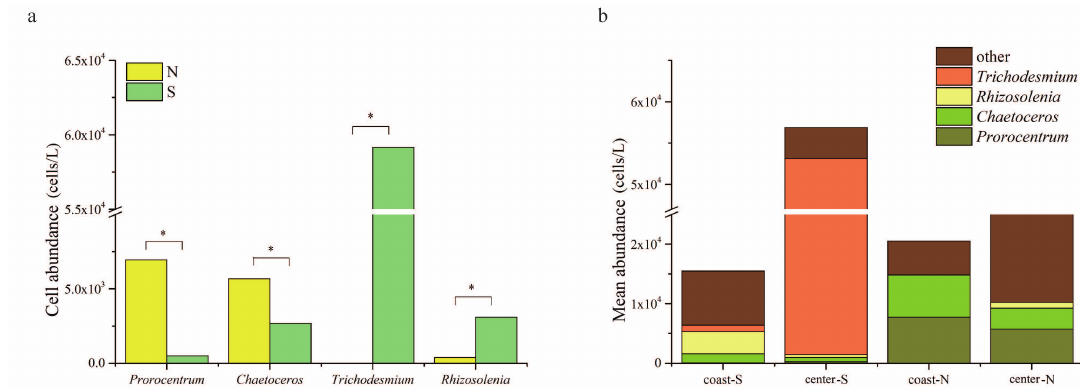
Figure 2. Di ff erences in the abundance of dominant phytoplankton taxa between the Northern and Southern region ( a ), and between the coast and center ( b ) in Taiwan Strait.